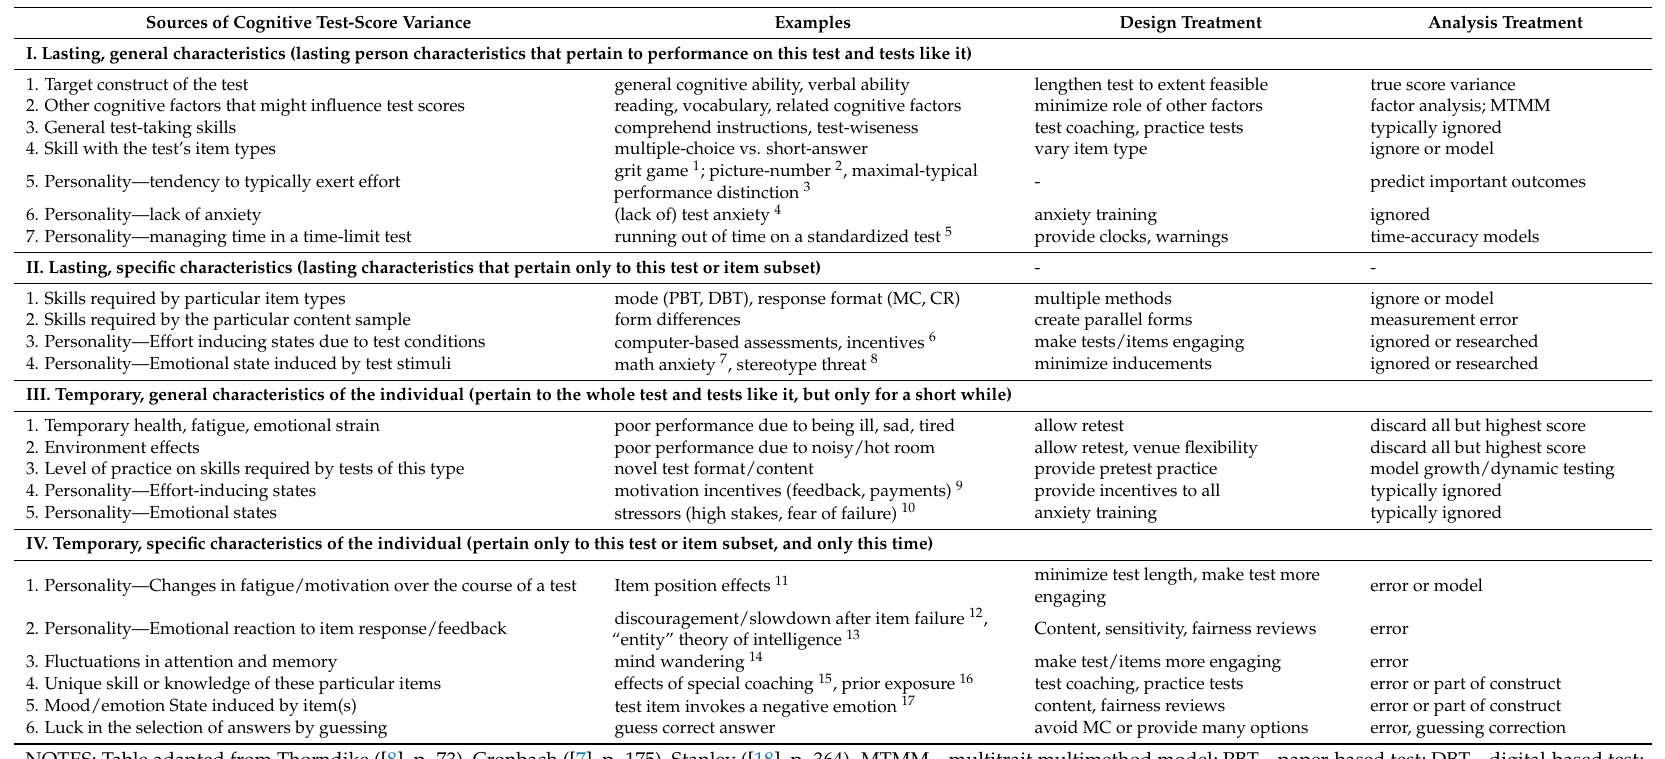
Table 1. Sources of cognitive test score variance, including personality trait and state